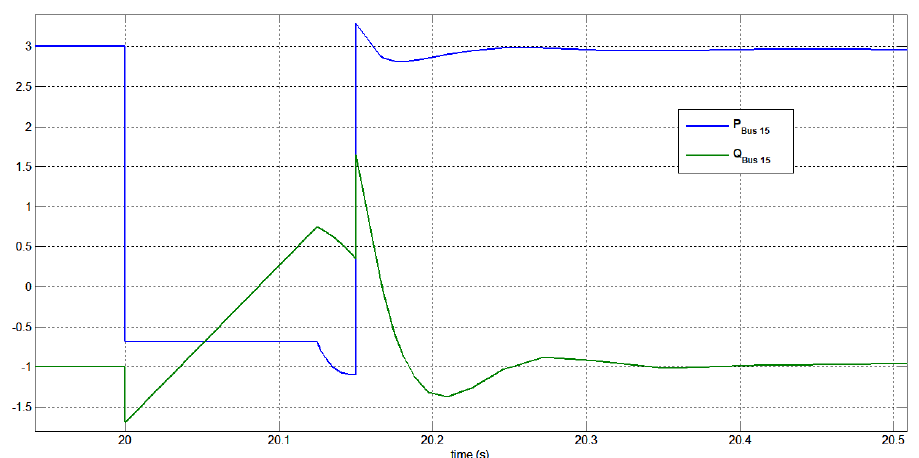
Figure 42. Generated active and reactive power at bus 15 under a three-phase short circuit at bus 15 without STATCOM.